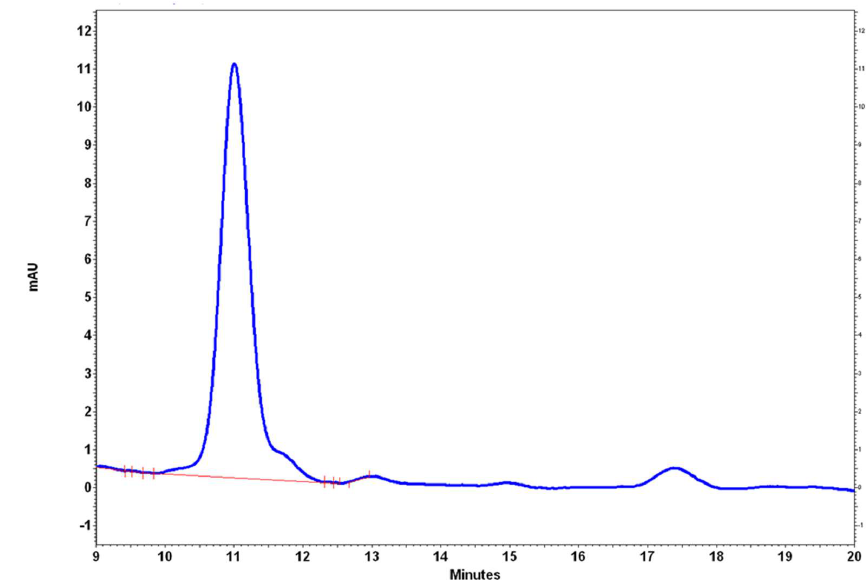
Figure 2. Isolated Parvifloron D spectra by High-Performance Liquid Chromatography (HPLC) analysis.